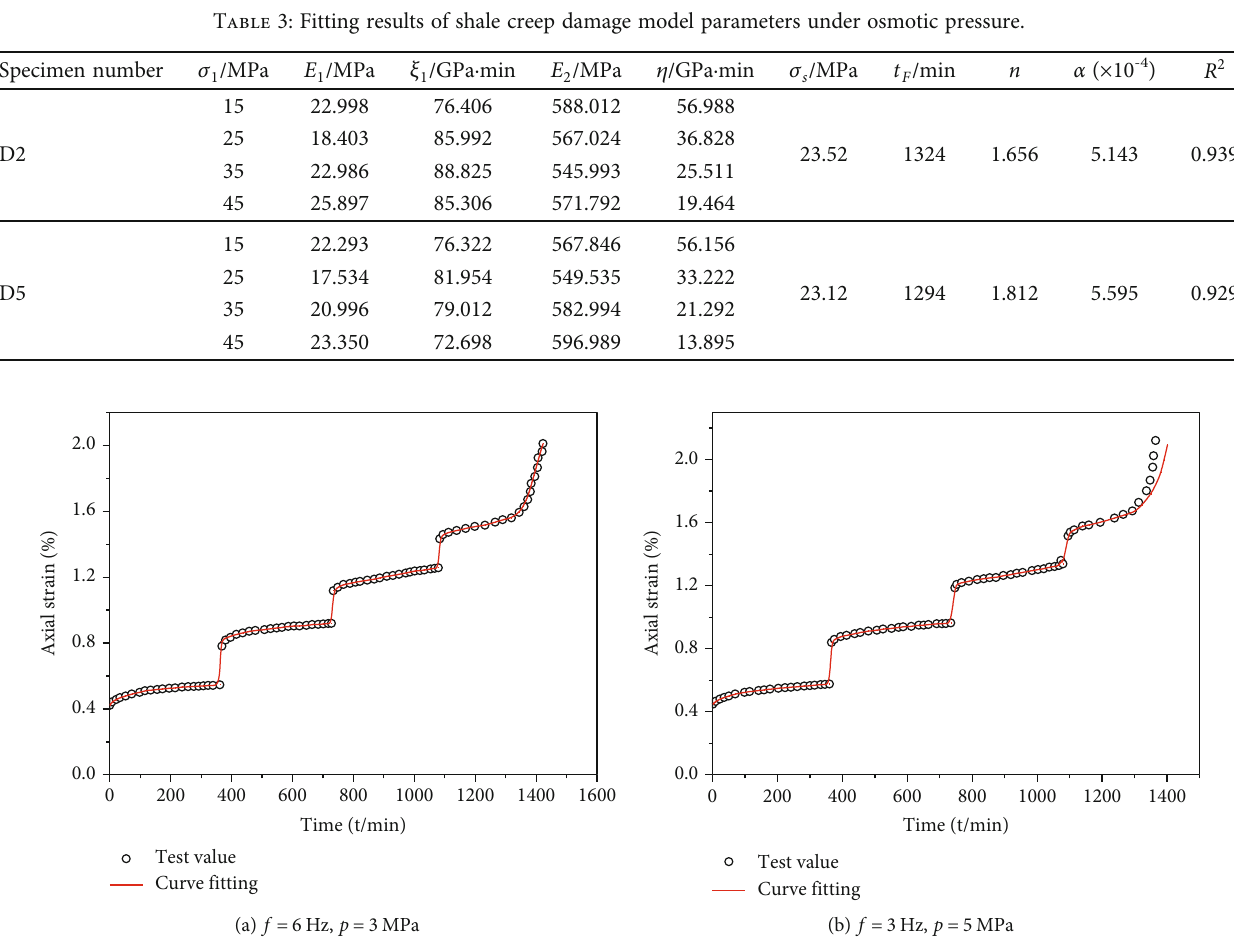
Figure 9: Time-strain curve fi tting diagram of rock creep.